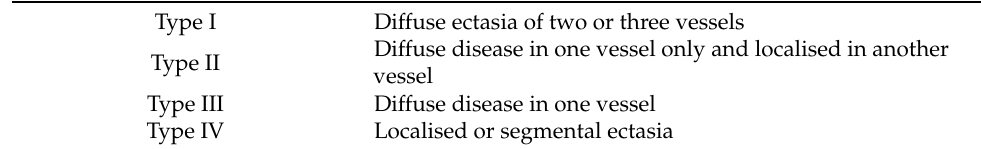
Table 1. Markis classification of coronary artery